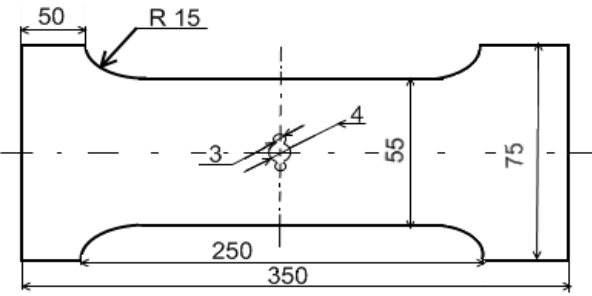
Figure 1: Geometry of specimen. All sizes are in